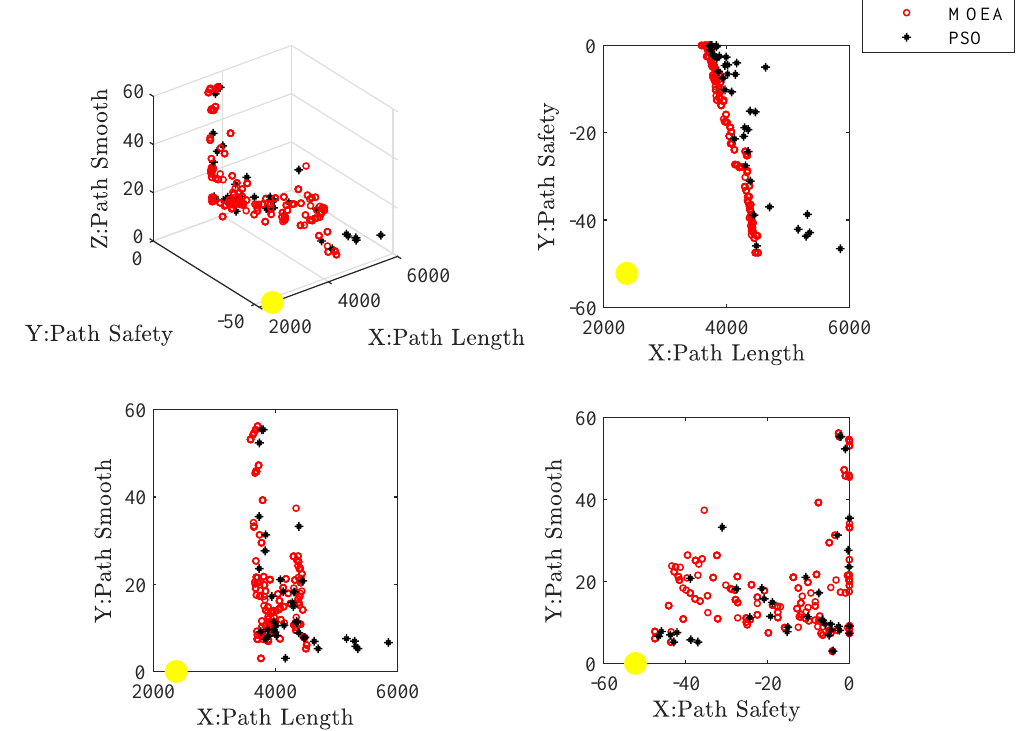
Figure 13. Approximate Pareto fronts for Figure 8E: MOEA vs. PSO.